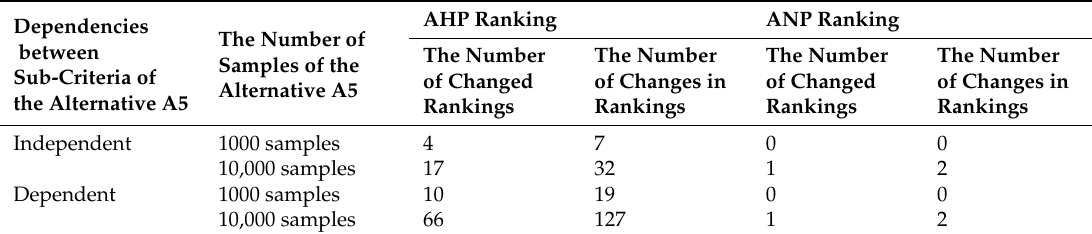
Table 12. The occurrence of the rank reversal phenomenon in examined rankings depending on the way of generating the alternative A5.